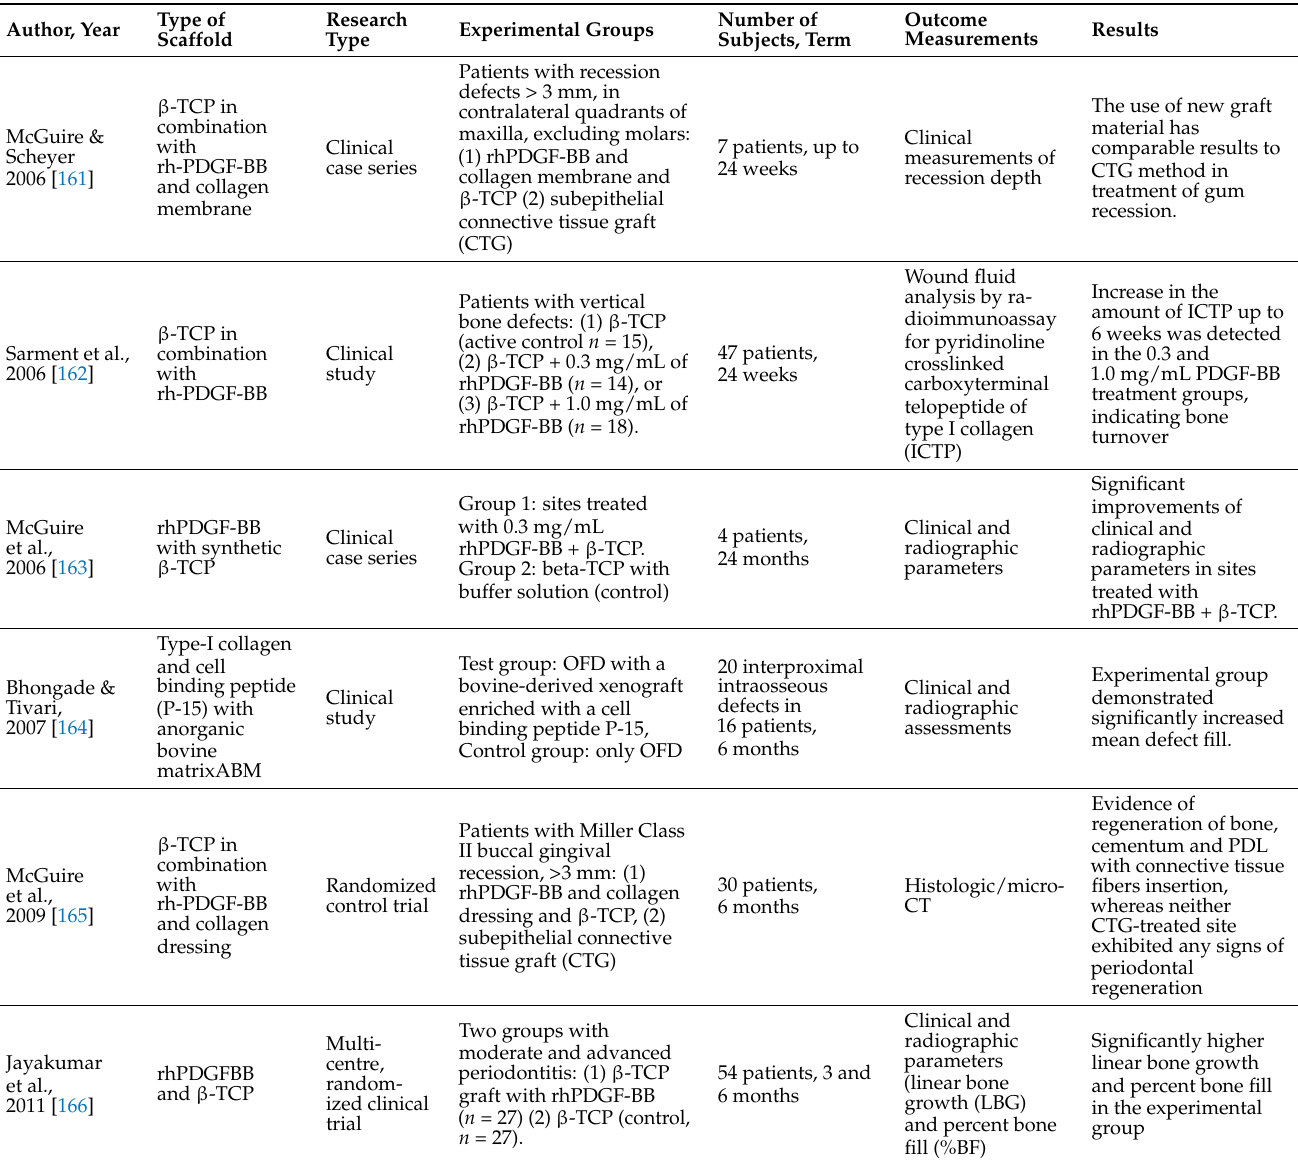
Table 3. Clinical studies involving scaffolds and growth factors for periodontal tissue